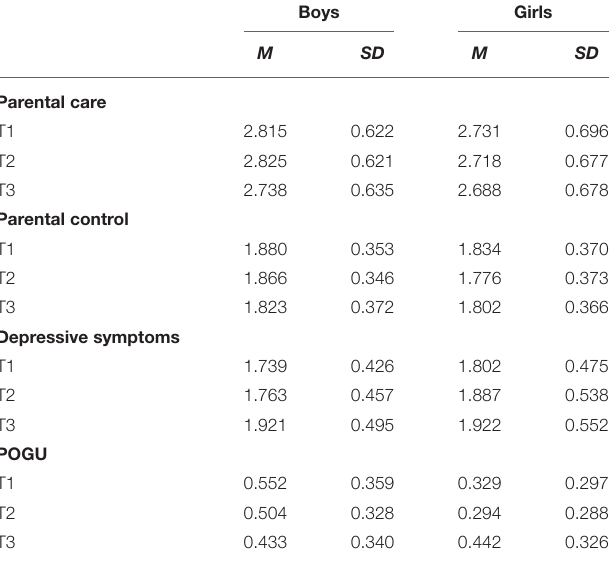
TABLE 1 | Descriptive statistics for main study variables.